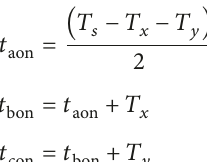
Following the same principle, the dwell time of each vector, we achieve 𝑉 ref of different sectors. To facilitate the solution, we may define it as (7). The value of 𝑇 1 and 𝑇 2 at different sectors could be set according to Table